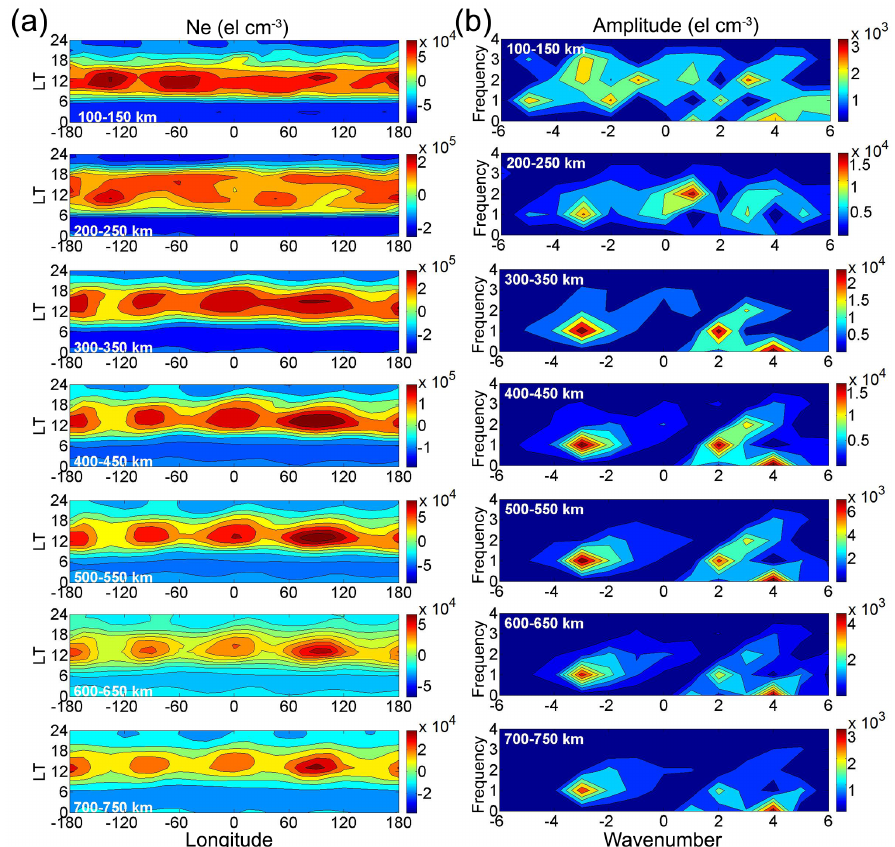
Figure 6. 2008 September equinox period Ne LT contour plots. (a) LT × longitude maps for electron densities (Ne) for some altitudes of the 50km interval, during the 2008 September equinox period. (b) Amplitudes obtained for their respective non-migrating tides indicating their frequency (1/day) and respective zonal wavenumber. The corresponding altitude intervals used are indicated in the plots. The color scale, in elcm − 3 , is shown at the right side of each